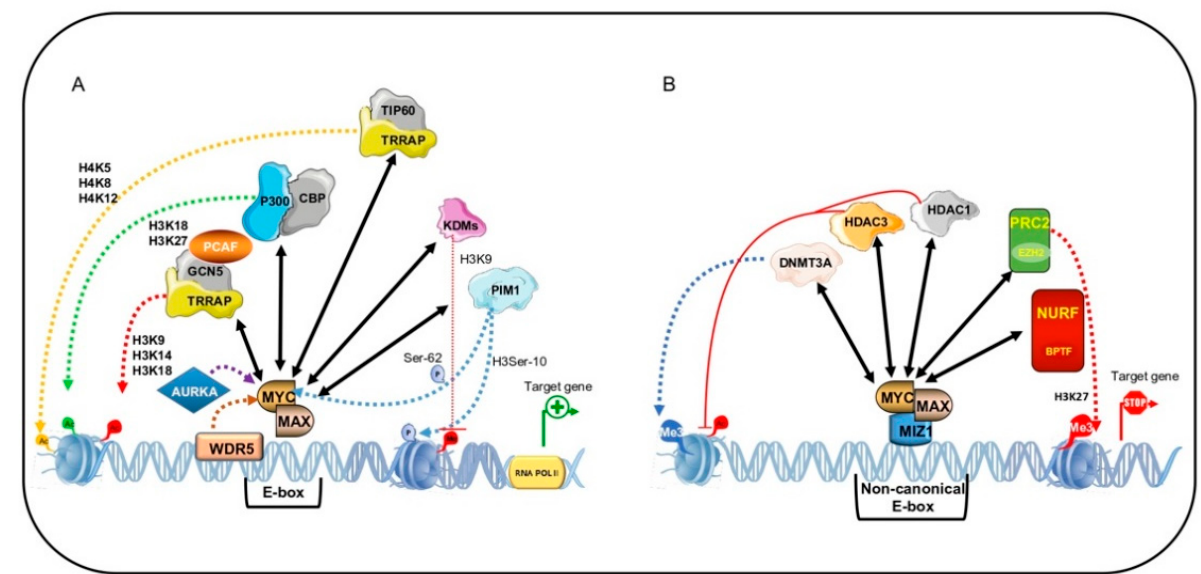
Figure 3. MYC-mediated transactivation and transrepression of target genes. Transcriptional activation of target genes ( A ). MYC:MAX heterodimer binds E-box sequences and transactivates canonical target genes through recruitment of chromatin modifying co-factors. TIP60 and GCN5 via transformation/transcription domain-associated protein (TRRAP) and p300/CBP, respectively, increase acetylation of histone H3 and H4, inducing an open chromatin conformation allowing RNA polymerase II machinery to bind the core promoter. Histone demethylases (KDMs) regulate the methylation of histone H3 by removing repressive chromatin marks, thereby contributing to gene activation. PIM1 phosphorylates histone H3 and MYC increasing its stability. Aurora A protein kinase (AURKA) phosphorylates and stabilizes MYC. WDR5 is crucial for recruitment of MYC at chromatin regions. Transcriptional repression of target genes ( B ). MYC:MAX/MIZ1-mediated transrepression of non-canonical target genes involving recruitment of chromatin co-repressors. MYC:MAX/MIZ-1 complexes recruit DNMT3A to non-canonical targets, thereby increasing tri-methylation of histone H3, promoting tumor cell proliferation rather than differentiation and senescence. HDAC1 and HDAC3 contribute to histone deacetylation and thus gene silencing. EZH2 is a member of PRC2 that catalyzes tri-methylation of histone H3 to enhance gene silencing. Bromodomain PHD finger transcription factor (BPTF) is necessary for MYC transcriptional